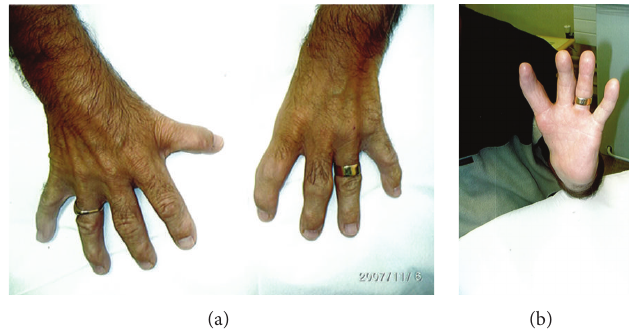
Figure 1: The patient’s hands exhibit radial foreshortening, digit aplasia, and triphalangeal thumb of the right